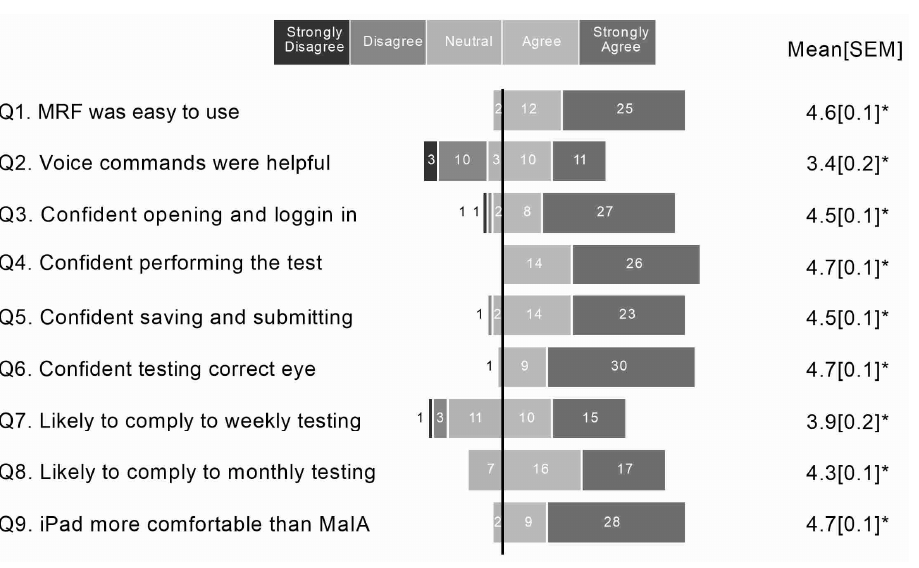
Figure 6. Survey responses on the ease of use of the MRF iPad application from n = 40 participants with iAMD. * Indicates mean is significantly removed from the neutral state of 2.5, p < 0.01. MAIA = Macular Integrity Assessment.